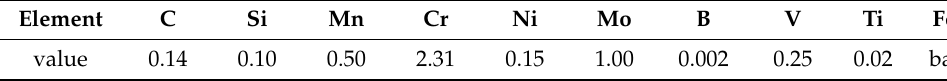
Table 1. Chemical composition of 2.25Cr1Mo0.25V steel in wt.%.